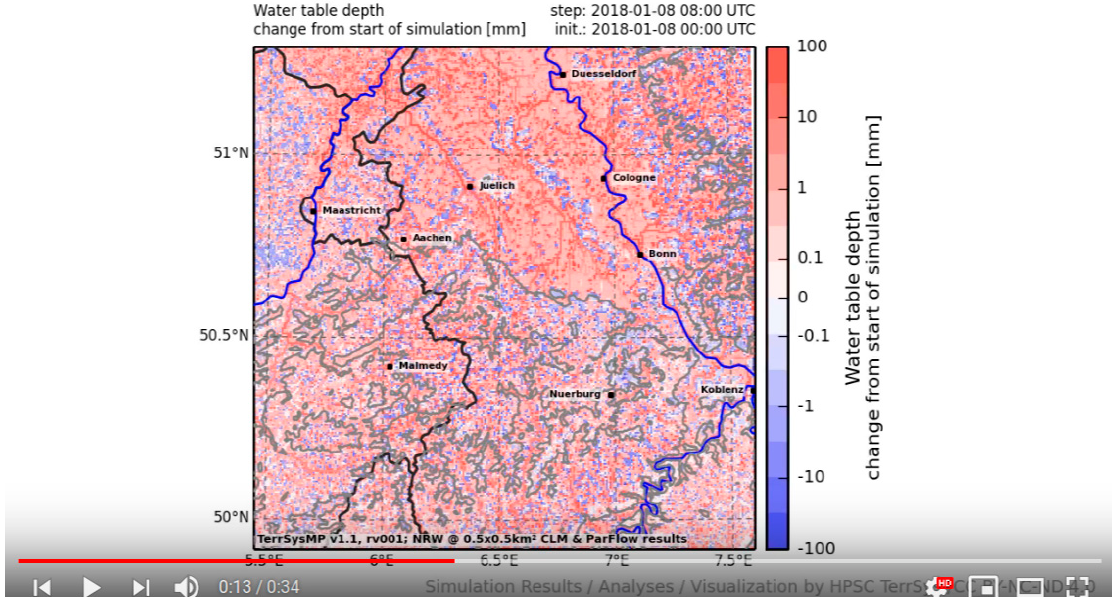
Figure 8. Monitoring output of TSMP (NRW) for the water table depth change (mm) in logarithmic scale. The change is estimated relative to the initial condition at the beginning of the monitoring run. Negative values indicate a rise of the water table.